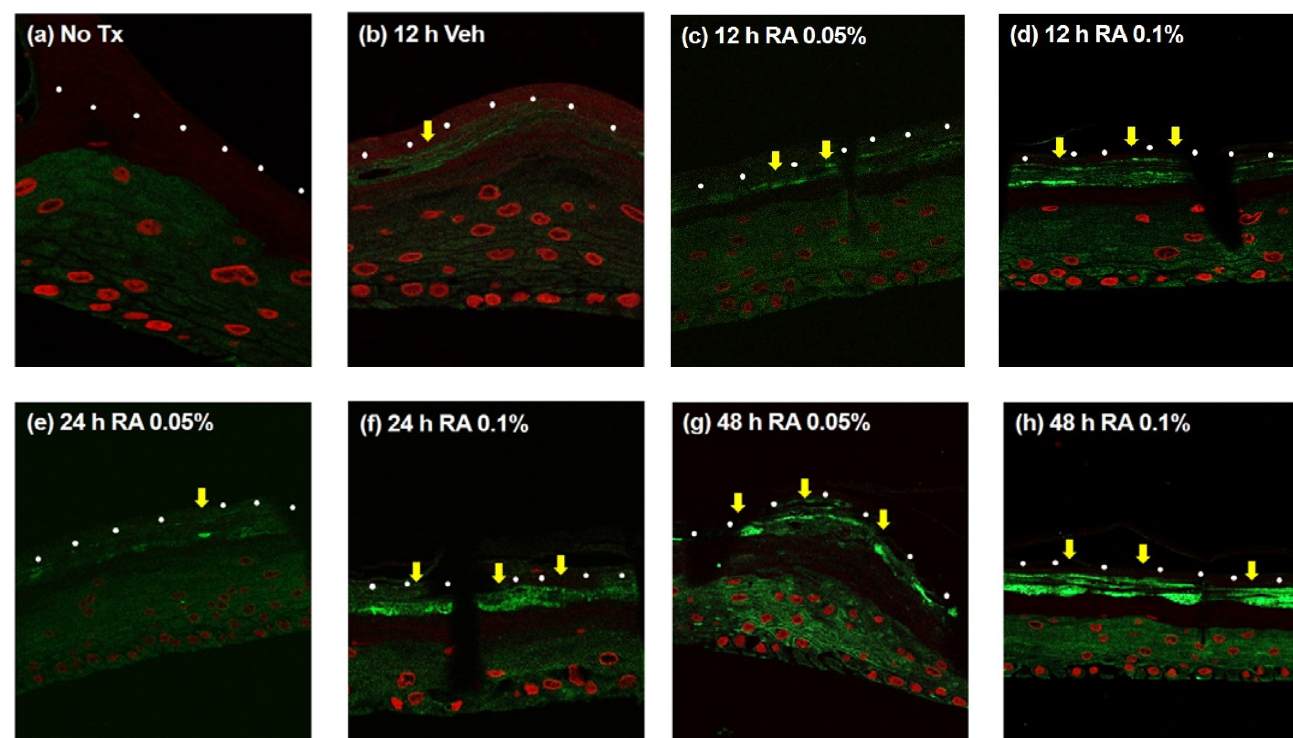
Figure 3. Immunofluorescence (IF) staining for analyzing NHE1 expression in 3D-cultured skin after topical application. IF staining for NHE1 expression after application of the NHE1 activator cream (containing 0.05% or 0.1% rosmarinic acid) or the vehicle cream. ( a ) No treatment, ( b ) 12 h after vehicle cream application, ( c ) 12 h after rosmarinic acid 0.05% cream application, ( d ) 12 h after rosmarinic acid 0.1% cream application, ( e ) 24 h after rosmarinic acid 0.05% cream application, ( f ) 24 h after rosmarinic acid 0.1% cream application, ( g ) 48 h after rosmarinic acid 0.05% cream application, and ( h ) 48 h after rosmarinic acid 0.1% cream application. The yellow arrows indicate NHE1 expression between the SC and SG. Red, nuclei of keratinocytes; white dots, interface between SC and SG. RA, rosmarinic acid; Veh, vehicle.